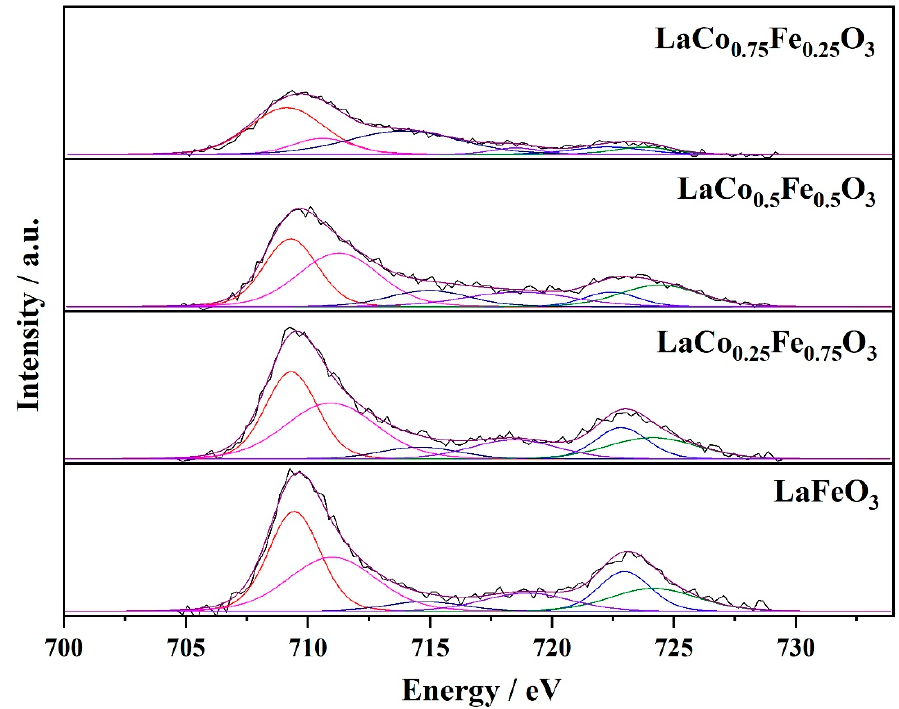
Figure 13. XPS spectra of Fe2p post-reaction.